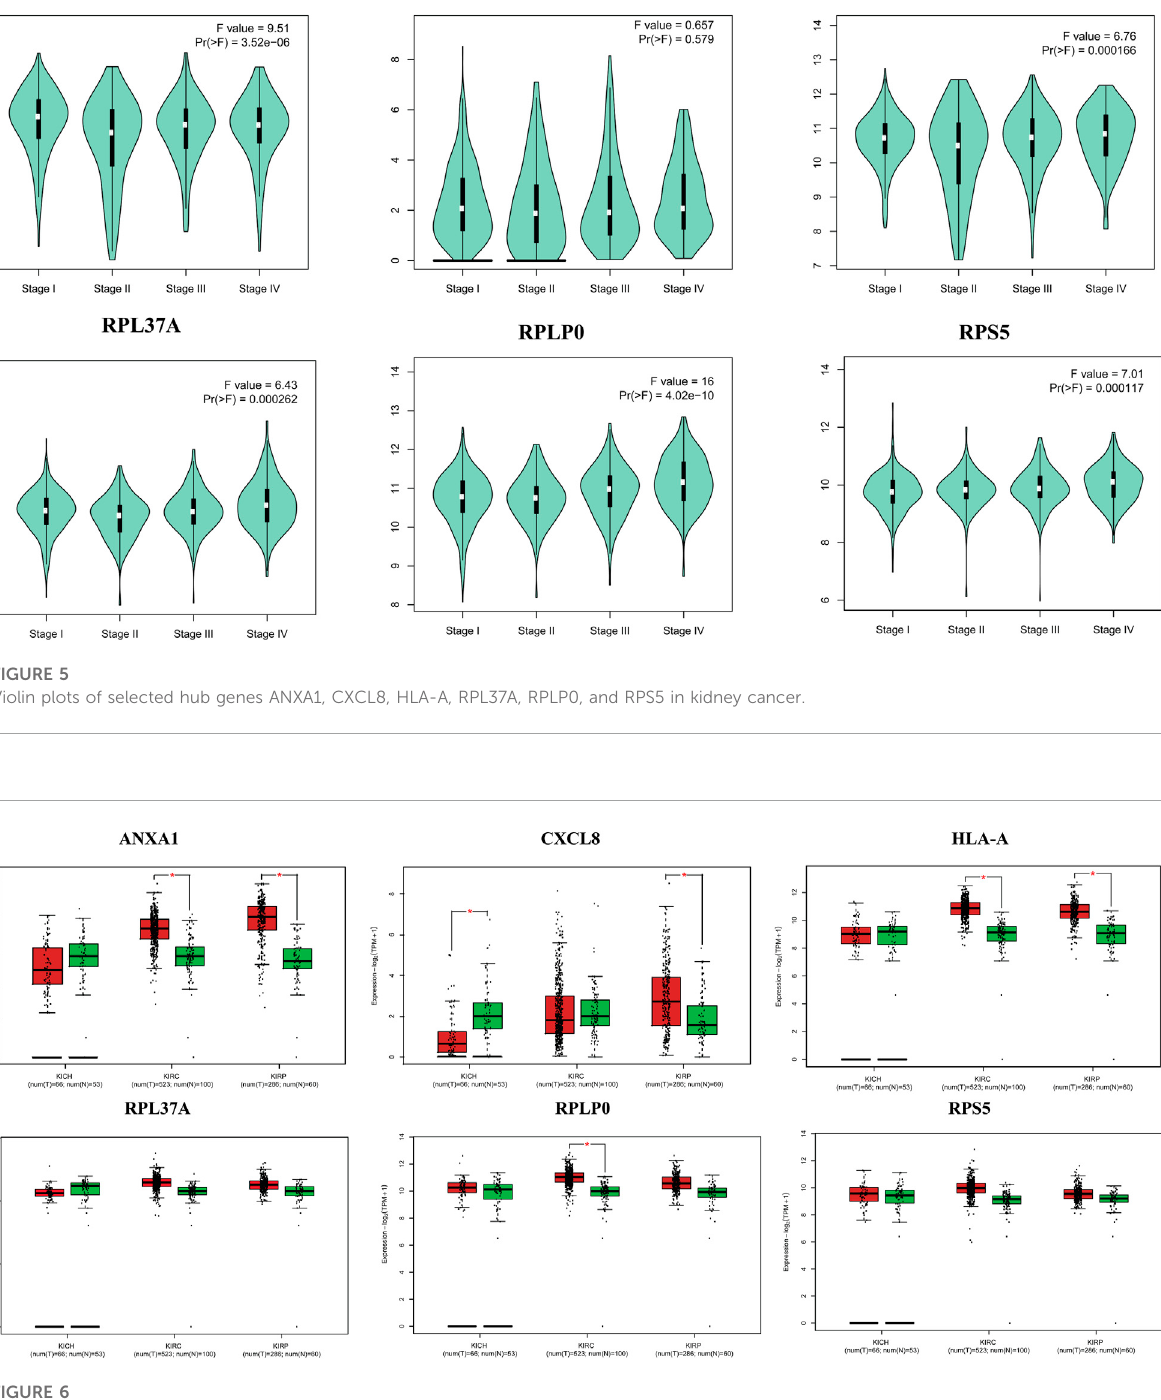
estimated through GEPIA (Figure 5). Further, we utilized GEPIA tool to validate the expression of hub genes using box plot analysis (Figure 6).